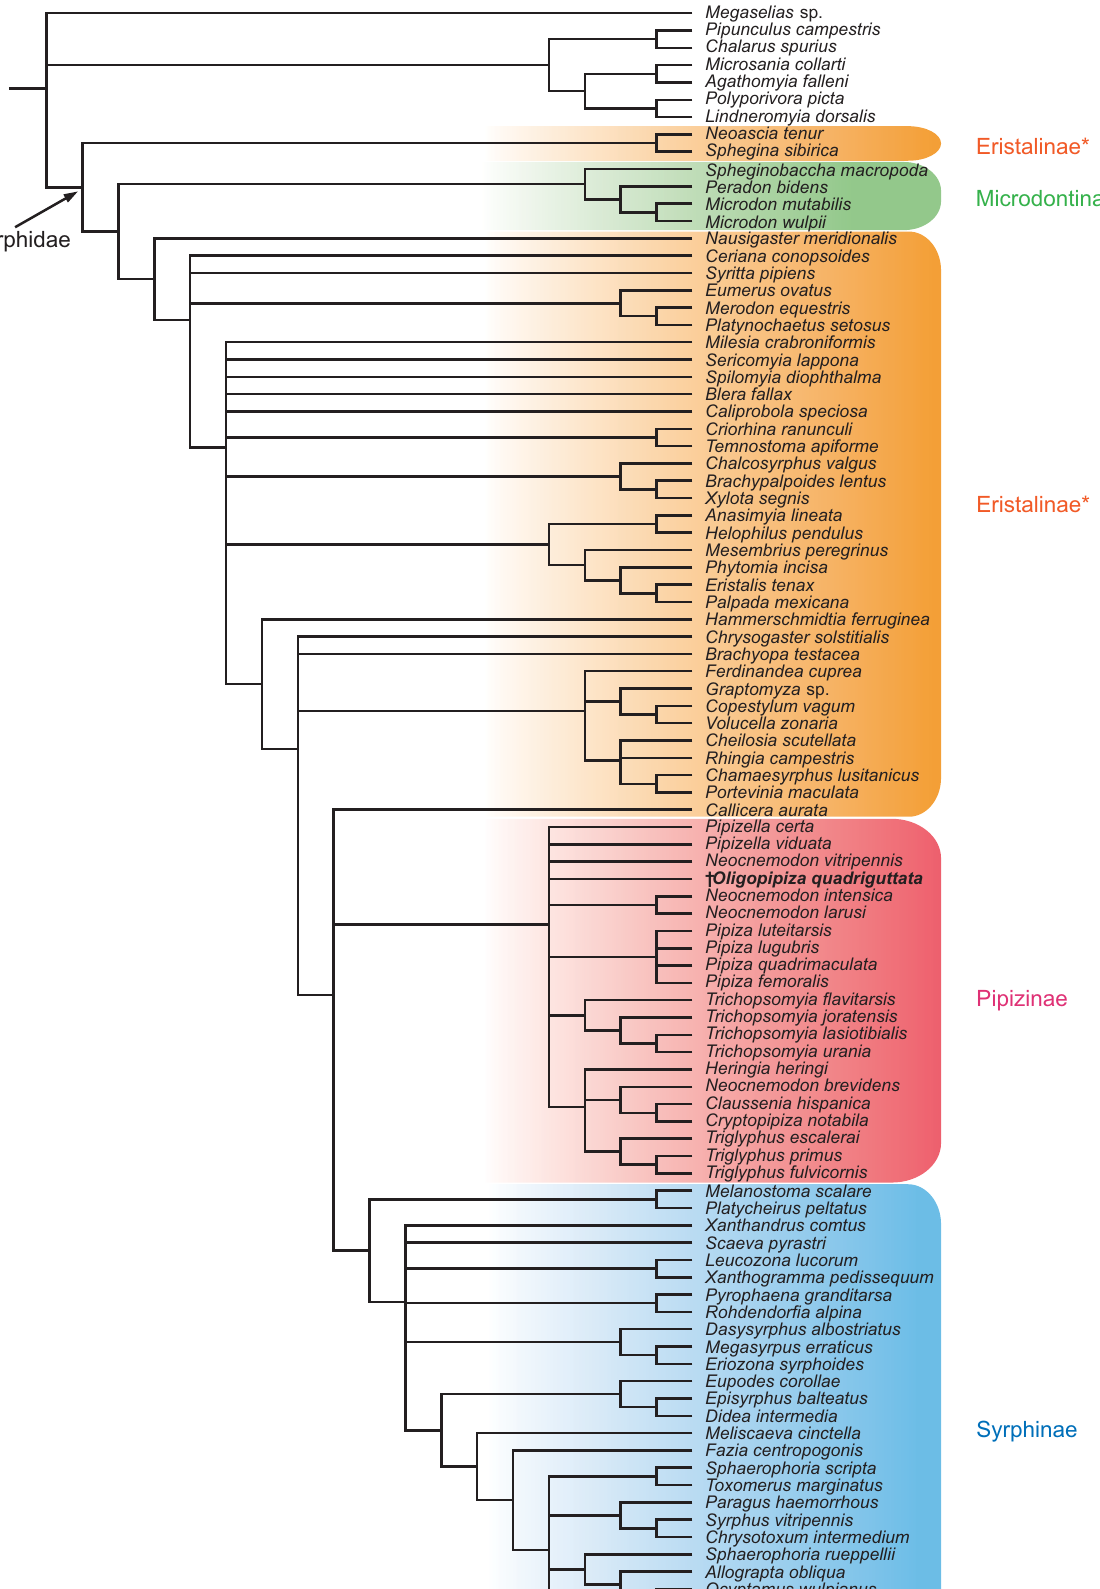
Fig. 8. Syrphid semi-strict consensus clado- gram based on morphological characters after Mengual et al. (2015), with Oligopipiza